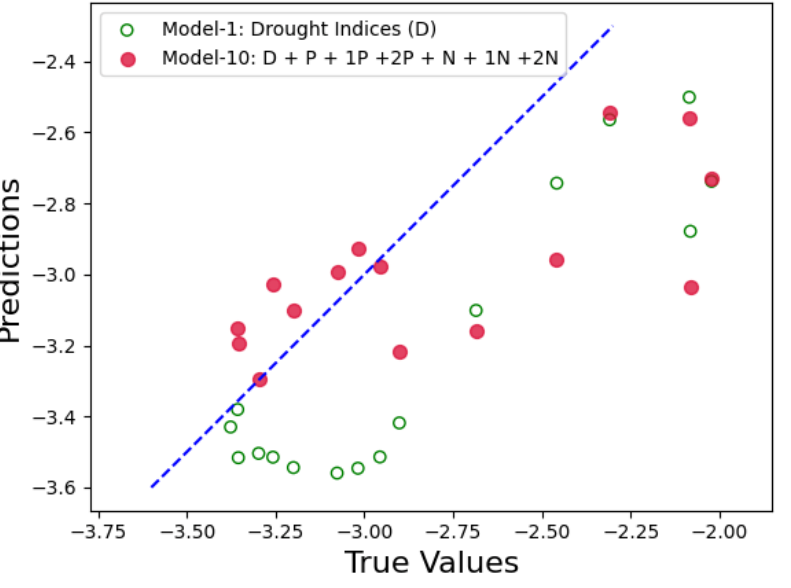
Figure 15. Result on unseen data during January-April 2021 using Support Vector Machine and Model 10 from Table 3. The x-axis represents the true or the actual PDSI values and the y-axis represents the predicted PDSI values. The red circles are the predictions by Model 10 and the green hollow circles in the figures are the predictions by the control run model. The blue dashed line is the reference line to test the model